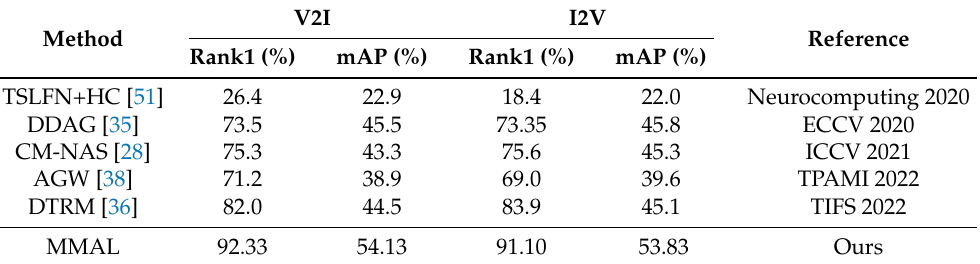
Table 2. The performance comparison of our MAL and state-of-the-art methods on the RGBNT201 dataset. The V2I and I2V denotes the visible-to-infrared and infrared-to visible retrieval